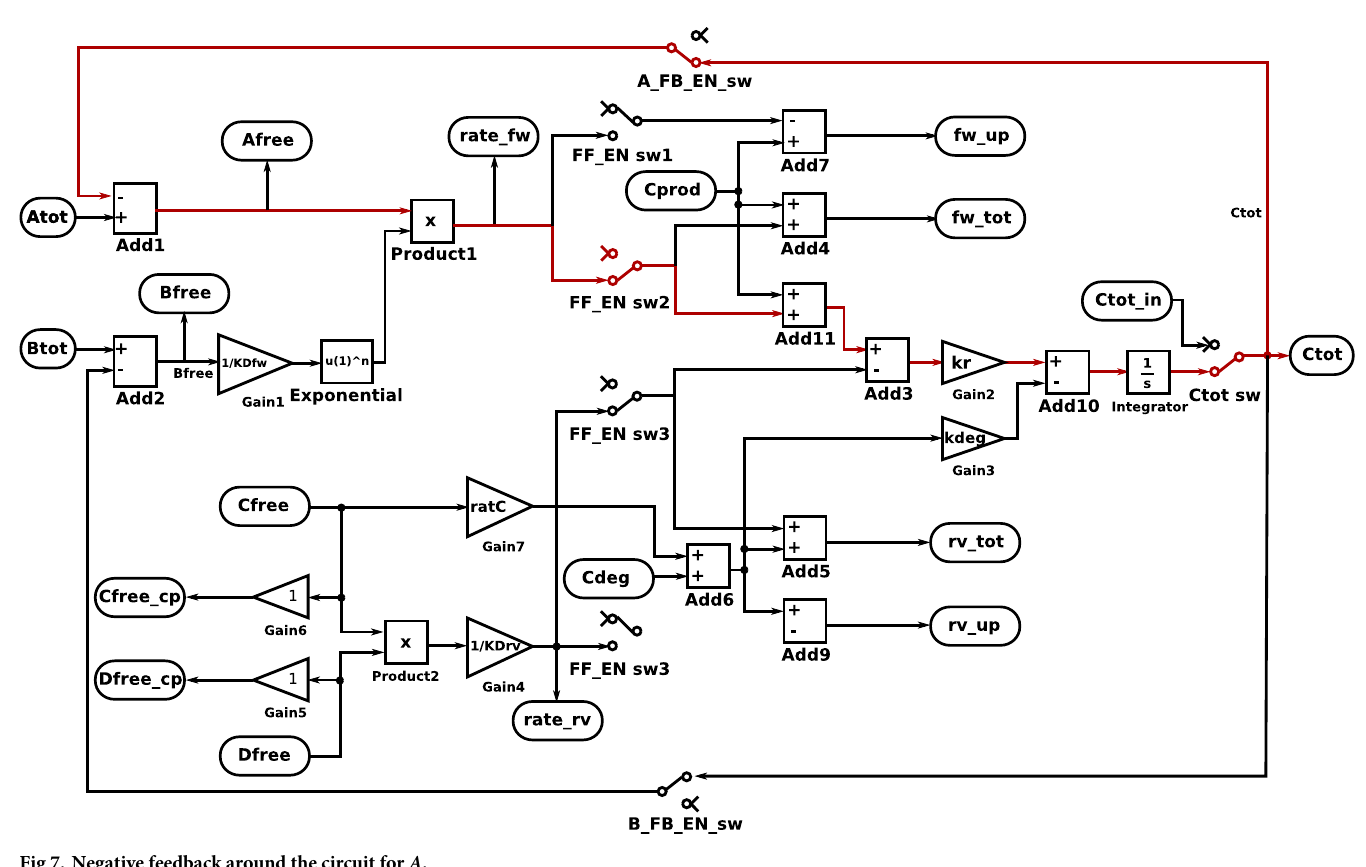
Fig 7. Negative feedback around the circuit for A